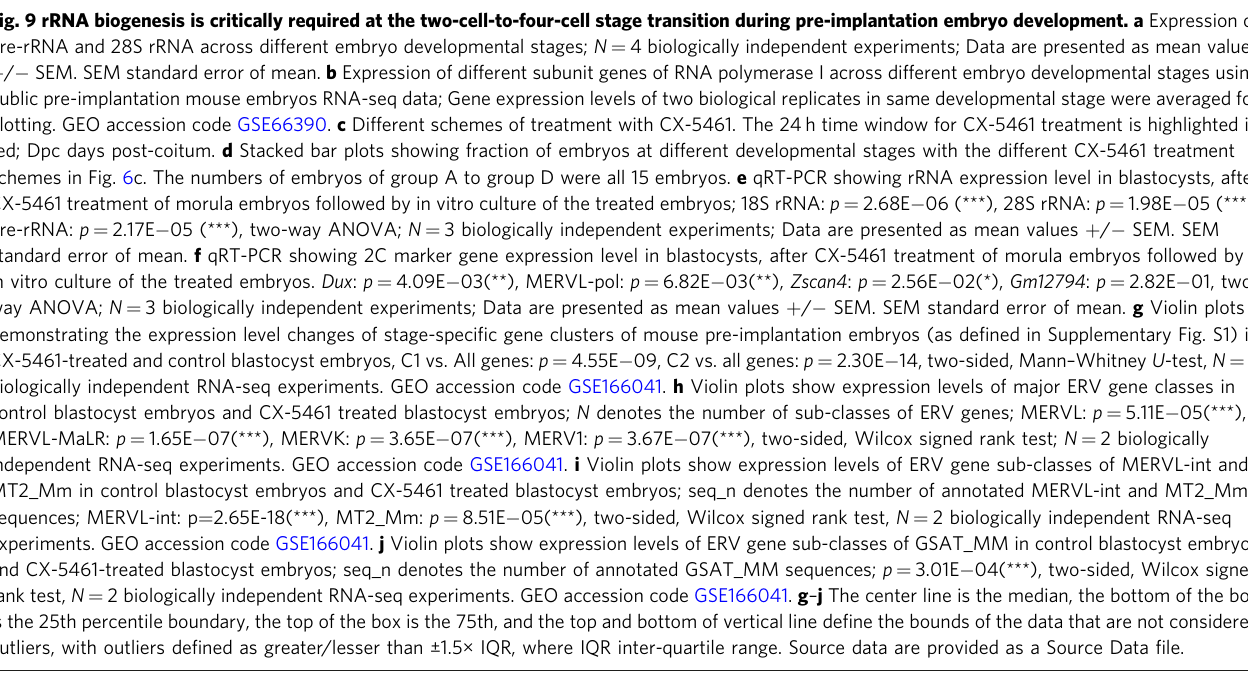
Fig. 9 rRNA biogenesis is critically required at the two-cell-to-four-cell stage transition during pre-implantation embryo development. a Expression of Pre-rRNA and 28S rRNA across different embryo developmental stages; N = 4 biologically independent experiments; Data are presented as mean values + / − SEM. SEM standard error of mean. b Expression of different subunit genes of RNA polymerase I across different embryo developmental stages using public pre-implantation mouse embryos RNA-seq data; Gene expression levels of two biological replicates in same developmental stage were averaged for plotting. GEO accession code GSE66390. c Different schemes of treatment with CX-5461. The 24 h time window for CX-5461 treatment is highlighted in red; Dpc days post-coitum. d Stacked bar plots showing fraction of embryos at different developmental stages with the different CX-5461 treatment schemes in Fig. 6c. The numbers of embryos of group A to group D were all 15 embryos. e qRT-PCR showing rRNA expression level in blastocysts, after CX-5461 treatment of morula embryos followed by in vitro culture of the treated embryos; 18S rRNA: p = 2.68E − 06 (***), 28S rRNA: p = 1.98E − 05 (***), Pre-rRNA: p = 2.17E − 05 (***), two-way ANOVA; N = 3 biologically independent experiments; Data are presented as mean values + / − SEM. SEM standard error of mean. f qRT-PCR showing 2C marker gene expression level in blastocysts, after CX-5461 treatment of morula embryos followed by in vitro culture of the treated embryos. Dux : p = 4.09E − 03(**), MERVL-pol: p = 6.82E − 03(**), Zscan4 : p = 2.56E − 02(*), Gm12794 : p = 2.82E − 01, two- way ANOVA; N = 3 biologically independent experiments; Data are presented as mean values + / − SEM. SEM standard error of mean. g Violin plots demonstrating the expression level changes of stage-speci fi c gene clusters of mouse pre-implantation embryos (as de fi ned in Supplementary Fig. S1) in CX-5461-treated and control blastocyst embryos, C1 vs. All genes: p = 4.55E − 09, C2 vs. all genes: p = 2.30E − 14, two-sided, Mann – Whitney U -test, N = 2 biologically independent RNA-seq experiments. GEO accession code GSE166041. h Violin plots show expression levels of major ERV gene classes in control blastocyst embryos and CX-5461 treated blastocyst embryos; N denotes the number of sub-classes of ERV genes; MERVL: p = 5.11E − 05(***), MERVL-MaLR: p = 1.65E − 07(***), MERVK: p = 3.65E − 07(***), MERV1: p = 3.67E − 07(***), two-sided, Wilcox signed rank test; N = 2 biologically independent RNA-seq experiments. GEO accession code GSE166041. i Violin plots show expression levels of ERV gene sub-classes of MERVL-int and MT2_Mm in control blastocyst embryos and CX-5461 treated blastocyst embryos; seq_n denotes the number of annotated MERVL-int and MT2_Mm sequences; MERVL-int: p = 2.65E-18(***), MT2_Mm: p = 8.51E − 05(***), two-sided, Wilcox signed rank test, N = 2 biologically independent RNA-seq experiments. GEO accession code GSE166041. j Violin plots show expression levels of ERV gene sub-classes of GSAT_MM in control blastocyst embryos and CX-5461-treated blastocyst embryos; seq_n denotes the number of annotated GSAT_MM sequences; p = 3.01E − 04(***), two-sided, Wilcox signed rank test, N = 2 biologically independent RNA-seq experiments. GEO accession code GSE166041. g – j The center line is the median, the bottom of the